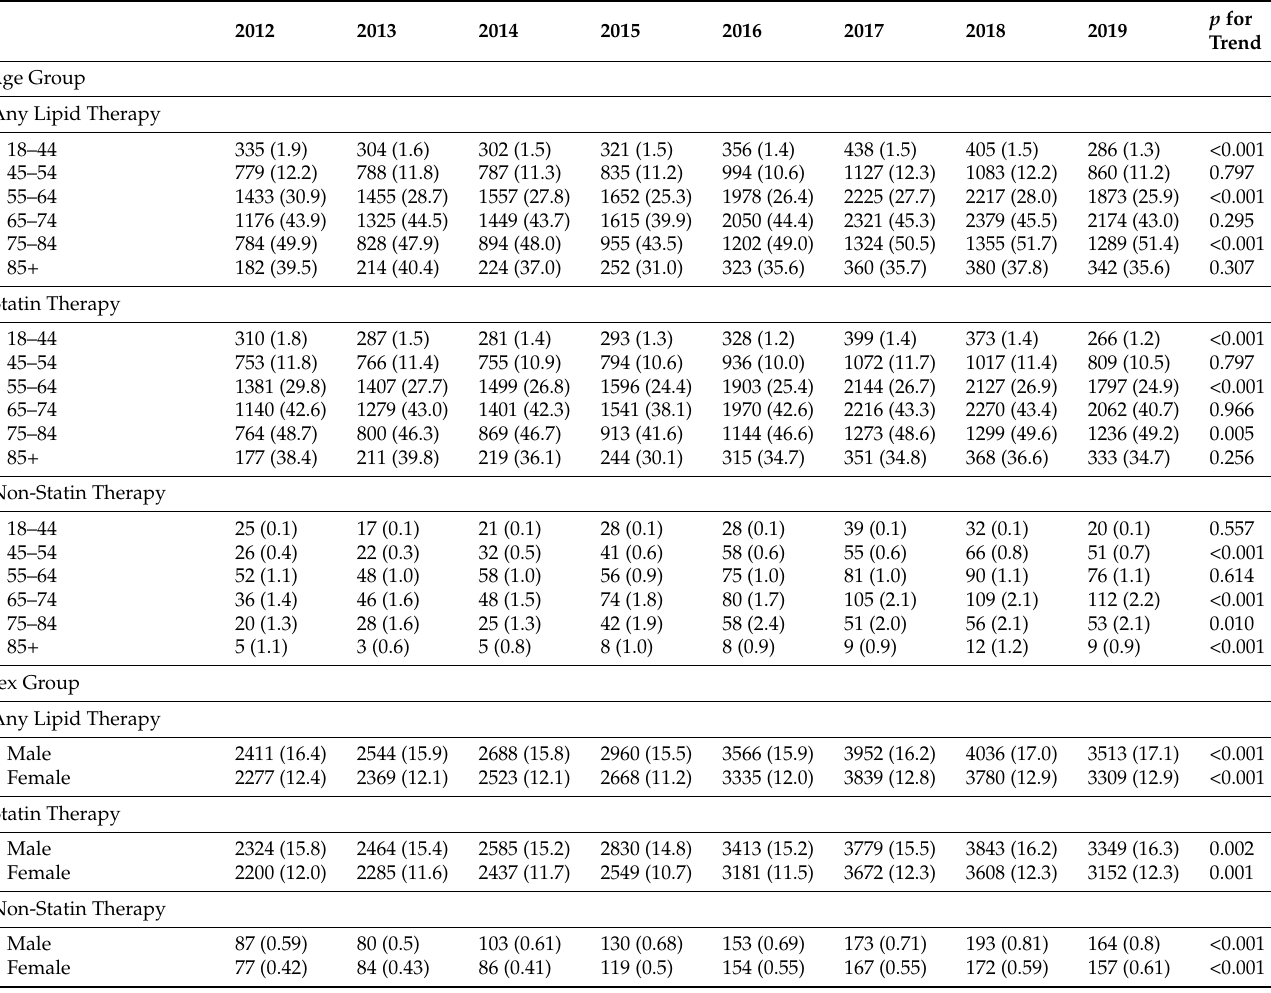
Table A6. Prevalence patterns within demographic